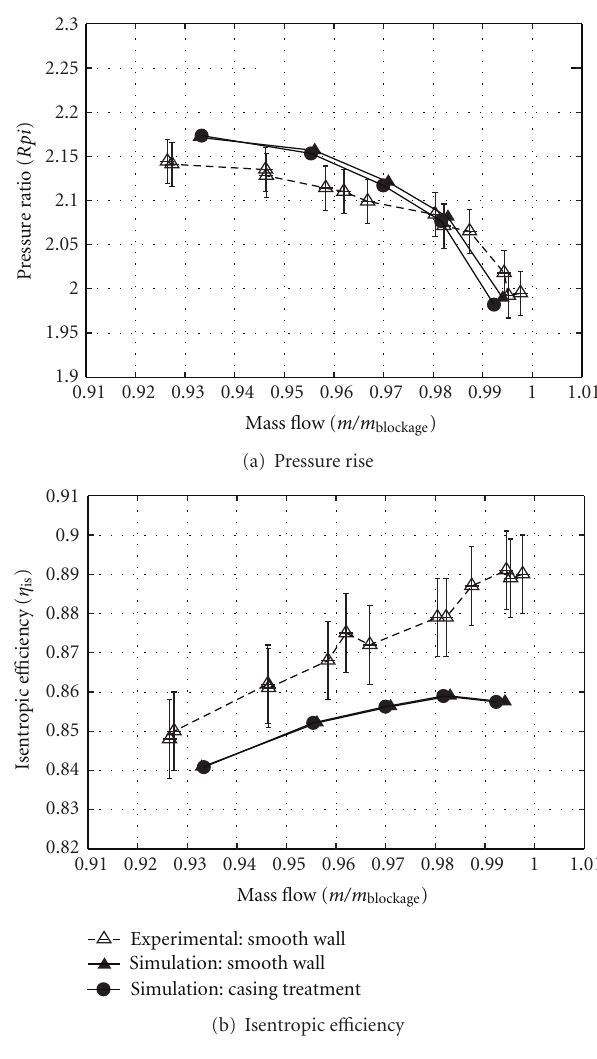
Figure 7: Predicted NASA Rotor 37 characteristics at design